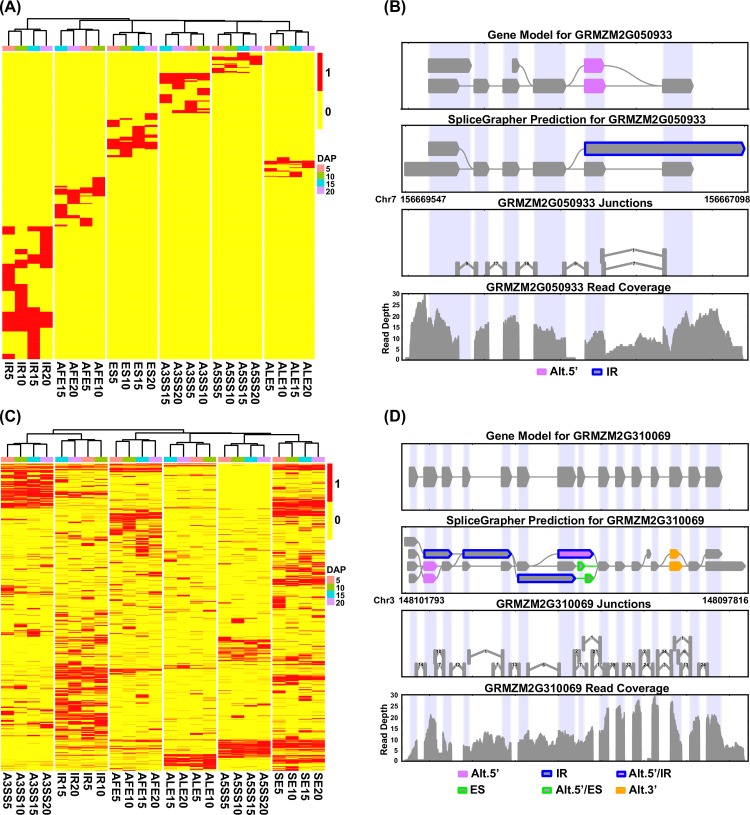
Discovery of a single AS event or multiple AS events in maize endosperm genes.(A) The heat map shows the dynamic changes in 5,905 genes with a single AS event during endosperm development, and the scale bar indicates whether an event occurred (red: event occurrence; yellow: no event occurrence). (B) An example of a single AS event occurring in a newly identified transcribed region (chromosome 7: 129960922–129965733); this developmentally regulated splicing event was only observed at 15 DAP. (C) Dynamic variation in multiple AS events in 5,116 genes is indicated at several developmental stages (the scale bar is defined in A). (D) An example of multiple AS events in GRMZM2G051866, indicating the diversity of newly identified transcribed regions (chromosome 10: 130393296–130404103) and the various developmentally regulated splicing events that occur at this locus during different developmental stages.